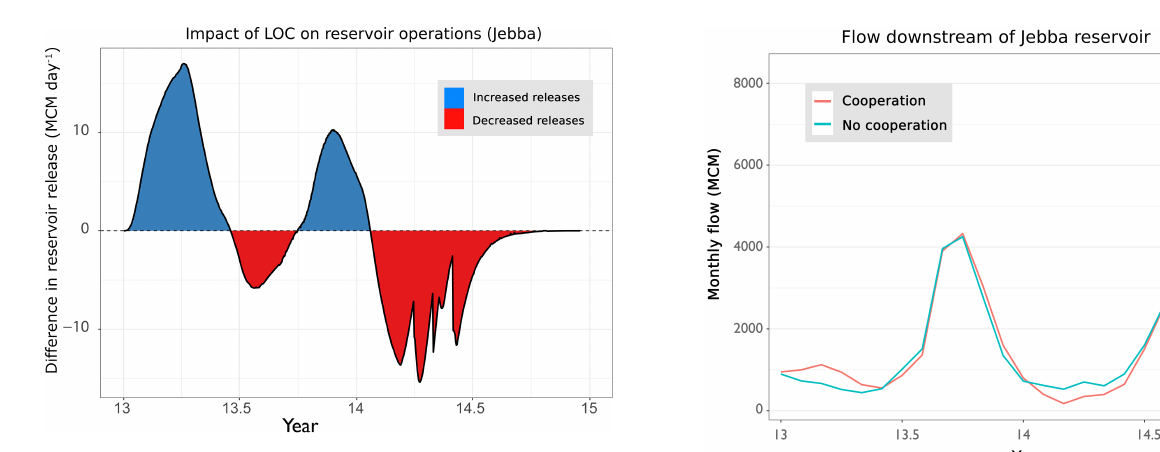
Figure 7. Change in reservoir release caused by the agent’s willing- ness to cooperate with downstream agents. The area in blue (red) represents additional (reduced) water released compared to model runs where the agent does not cooperate.